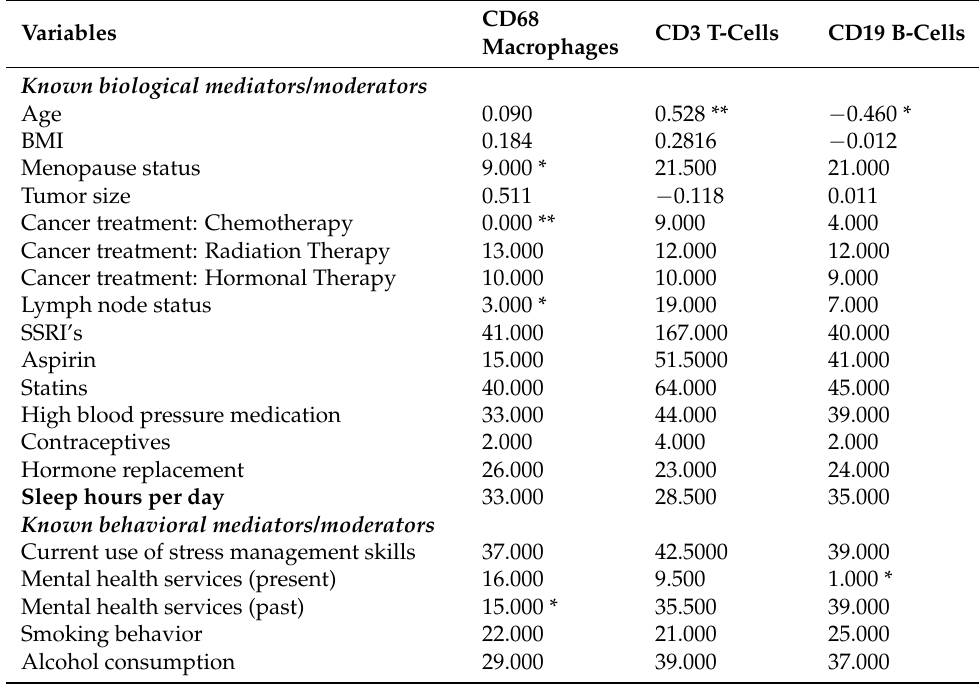
Table 2. Correlations among immune infiltration markers and known behavioral and biological mediators/moderators.